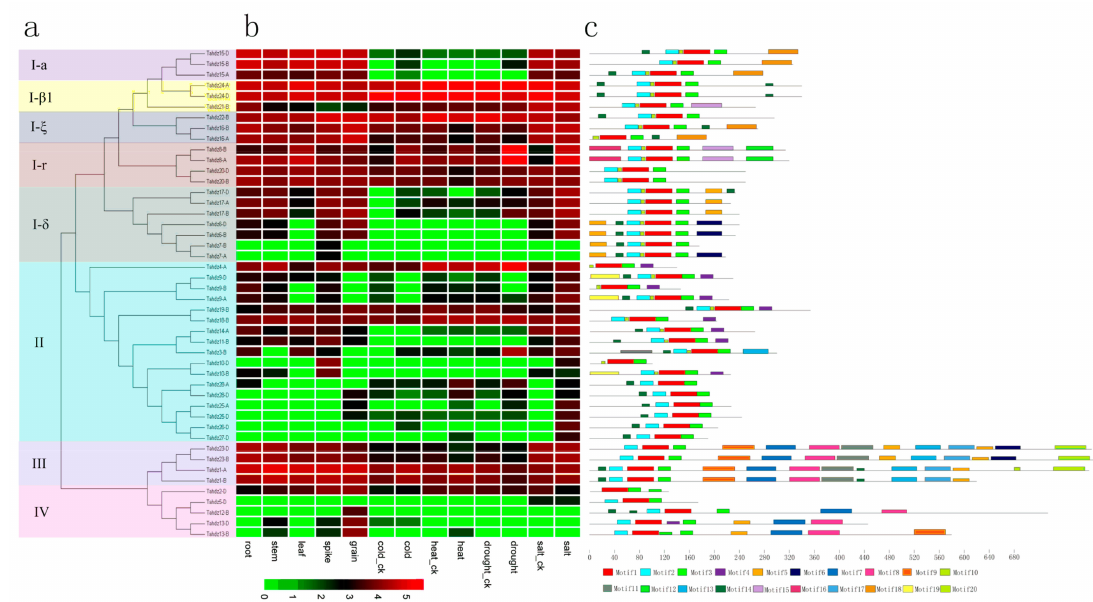
Figure 5. ( a ) Phylogenetic relationships; ( b ) Expression patterns; ( c ) Conserved motifs compositions of the 46 HD-Zip genes in wheat. ( a ) The phylogenetic tree was constructed based on the full-length protein sequences using MEGA6.0 (http://web.megasoftware.net/); ( b ) Hierarchical clustering of the relative expression level of TaHDZ genes. RNA-Seq data of five tissues and four stresses in Chinese spring was used to analysis expression pattern. The heat map was drawn in Log 10 -transformed expression values. Red or green colors represent decreased or increased expression level in each sample, respectively; ( c ) Multiple EM for motif elicitation (MEME) program [54] was used to predict conserved motifs. Each motif is represented by a different colored